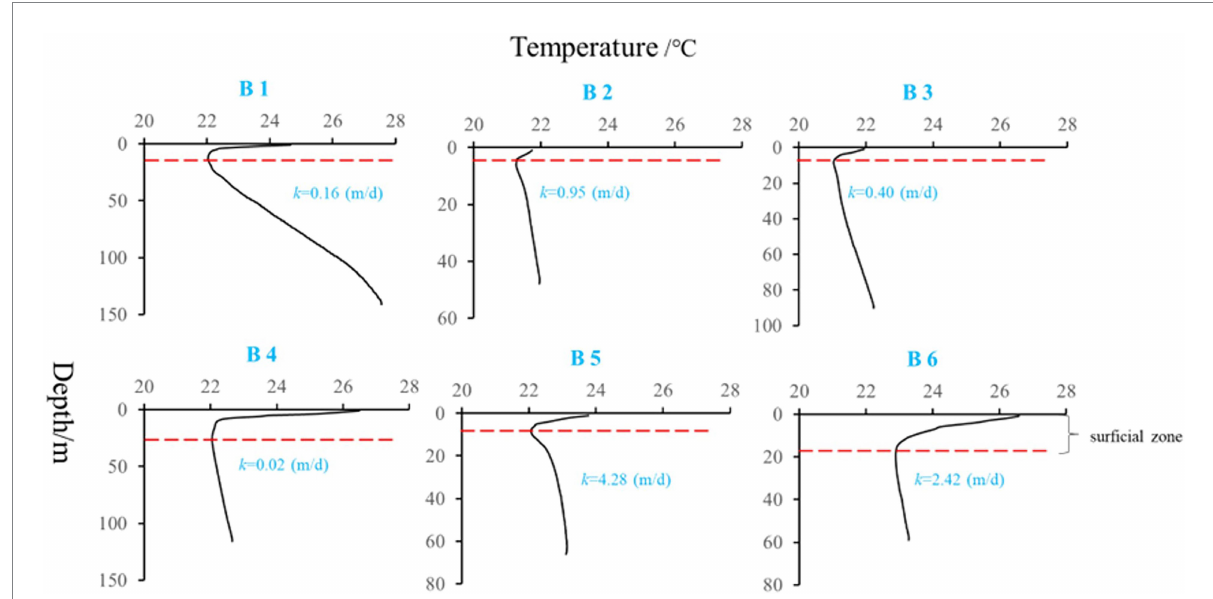
FIGURE 4 ‘Temperature-depth’ profiles of the selected boreholes (k, hydraulic conductivity; red dashed line, surficial zone boundary).